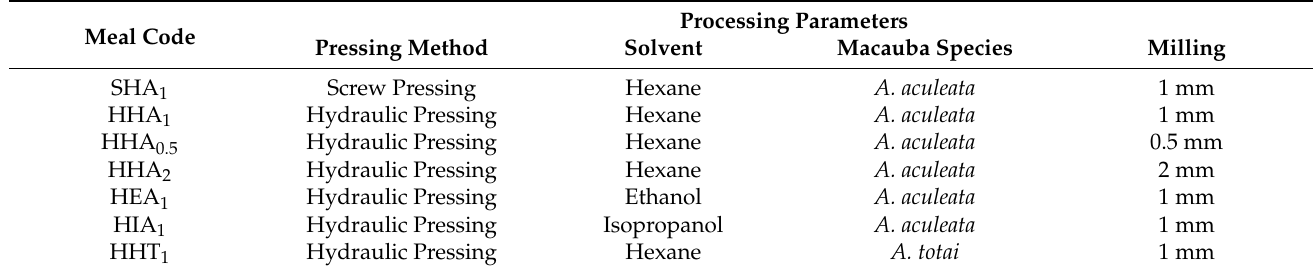
Figure 2. General processing of macauba kernels. Table 1. Parameters used for obtaining the deoiled macauba kernel meals .